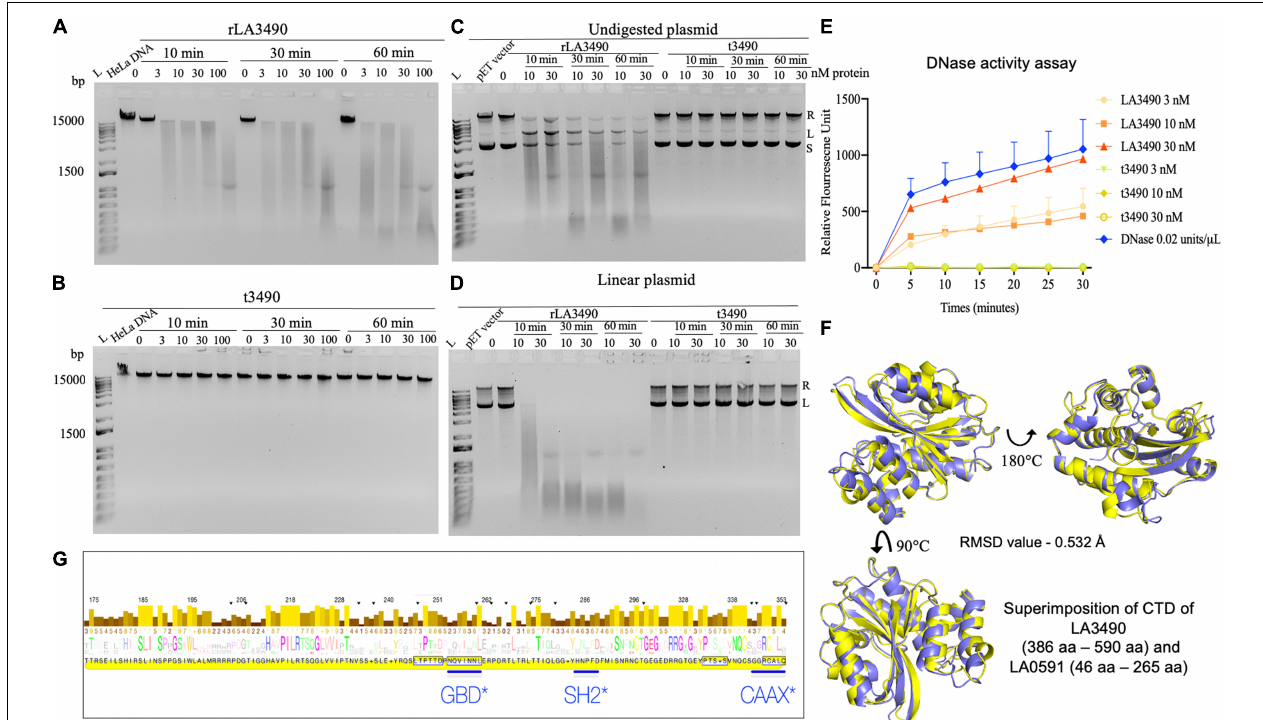
FIGURE 6 | DNase activity of leptospiral VM proteins. (A) DNase activity of rLA3490 observed upon incubation of 150 ng of DNA from HeLa cells in TM buffer containing 3 mM Mg 2 + for indicated dose and time (absence of Mg + 2 in reaction yielded no DNA degradation). Samples were subjected to 1% agarose gel electrophoresis. The DNase activity rLA3490 is indicated by smearing and disappearance of DNA; t3490 had no such effect. (B) Other recombinant VM proteins (LA0620, LA1400, LA1402, and LA0591) all had similar DNase activity (not shown). (C) DNase activity of rLA3490 on 400 ng of undigested plasmid pET28 shows partial degradation with uncoiling, linearizing, and partial degradation, and unaffected by t3490, shown by the white arrow. (D) DNase activity of rLA3490 on linearized plasmid shows complete disappearance of linear and relaxed plasmid, with dose- and time-dependent smearing. L, DNA ladder. (E) Quantification of rLA3490 DNase activity using real-time PCR and a FAM fluorescence probe. Bovine DNase, 0.02 U/ µ l, was used as positive control. Data represent the mean ± SD of three independent experiments. (F) Superimposition of AlphaFold generated CTD of LA3490 and LA0591, respectively. While LA3490 represents the vast majority of VM proteins with two RBLs, a CTD, and intervening functional sequences as visualized in Figure 1A , LA0591 lacks RBL1 and RBL2 but contains the rest of the functional sequences. This paralog represented by LA0591 is only fully present in L. interrogans species but not in other pathogenic Group I Leptospira. The CTDs of LA3490 and LA0591 are predicted to be highly conserved at the structural level despite amino acid sequence divergence, as shown by the RMSD values of 0.532 Å. (G) Eukaryotic trafficking motifs are present in the DNase-containing CTDs of leptospiral VM protein paralogs. GBD, GTPase-binding domain ligand, which is an amphipathic α -helix found in the C-terminal VCA segment of WASP/N-WASP proteins. SH2, Src Homology 2 domain, which is a broadly conserved protein interaction module central to tyrosine kinase signaling, and found in ubiquitin ligases, transcription factors, and guanine nucleotide exchange factors. The canonical CAAX motif is found in most Leptospira VM protein paralogs (but neither Q72UG2 nor